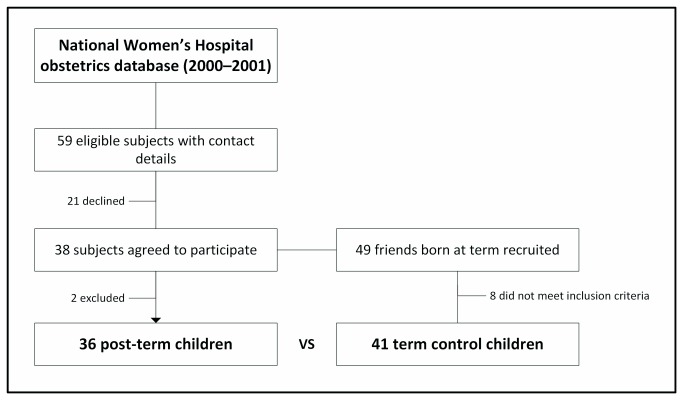
Summary of the study’s recruitment process.